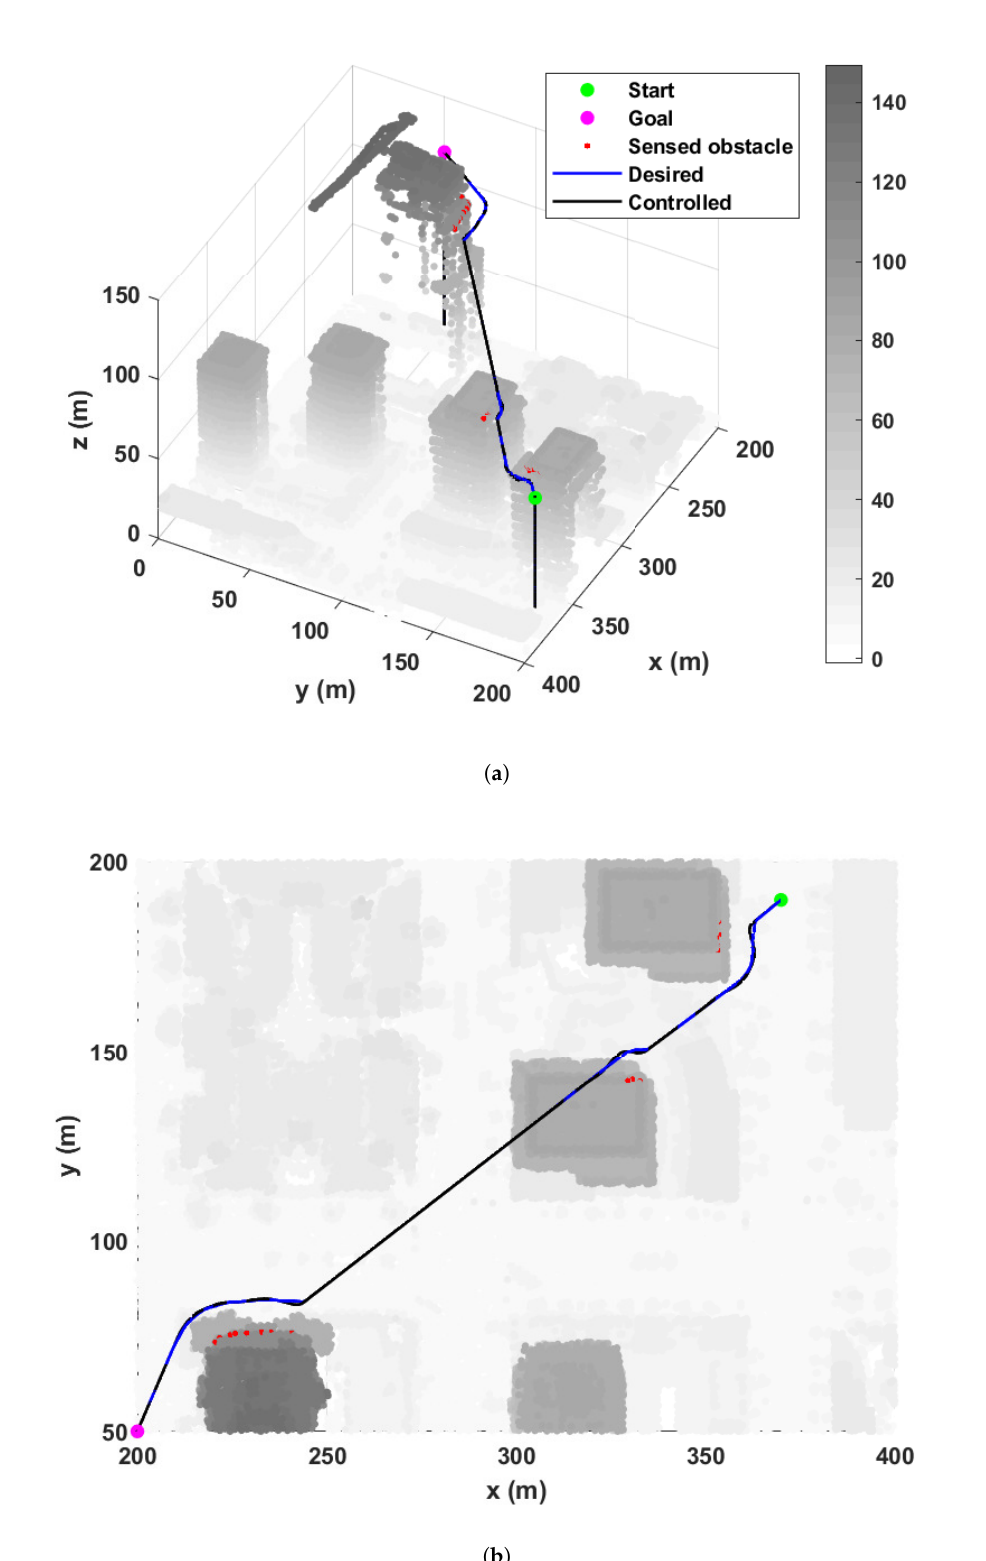
Figure 13. Case 3: Quadcopter’s trajectory in ( a ) 3D view and ( b ) top